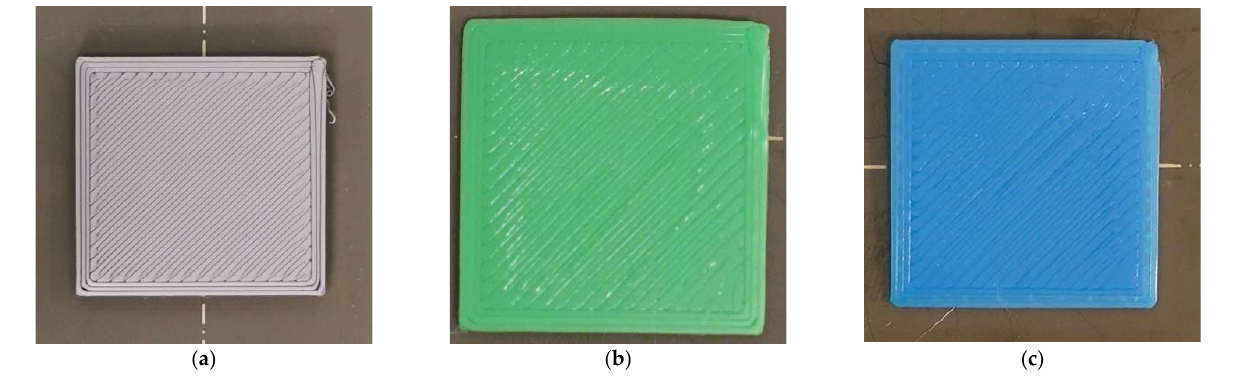
Figure 2. Photographs of ( a ) gray, ( b ) green, and ( c ) blue samples.